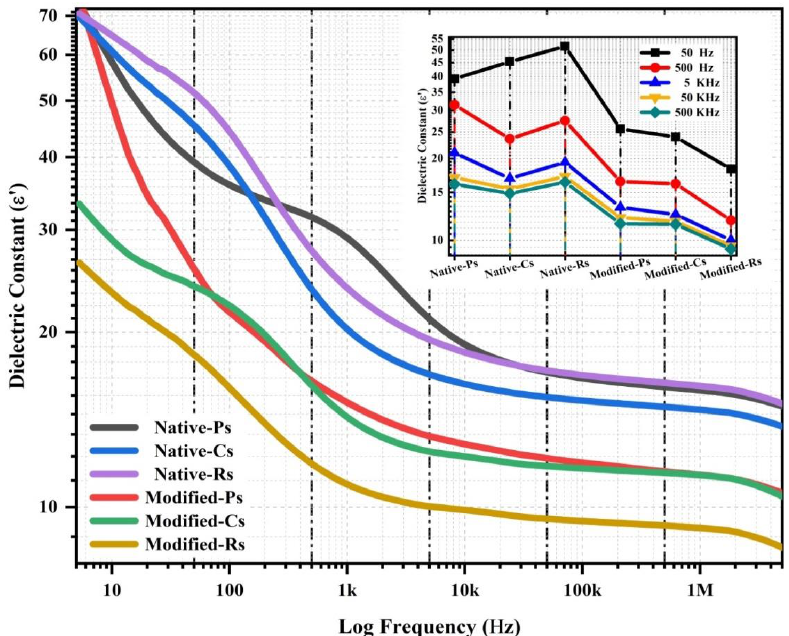
Figure 1. Frequency dependence of dielectric constant of native form and modified form of starches over the log frequency.